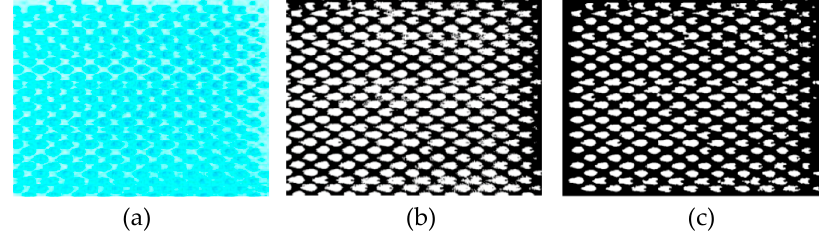
Figure 6. ( a ) Cyan dots; ( b ) binary image (with physical dot gain); ( c ) binary image after removal of dots connected to the borders and noise around dots. Due to the physical dot gain, we have a defor- mation of the printed dots. The shape and the size of the dots are thus deformed. Physical dot gain led to light cyan elliptic regions; meanwhile, printed dots correspond to dark cyan circular regions.